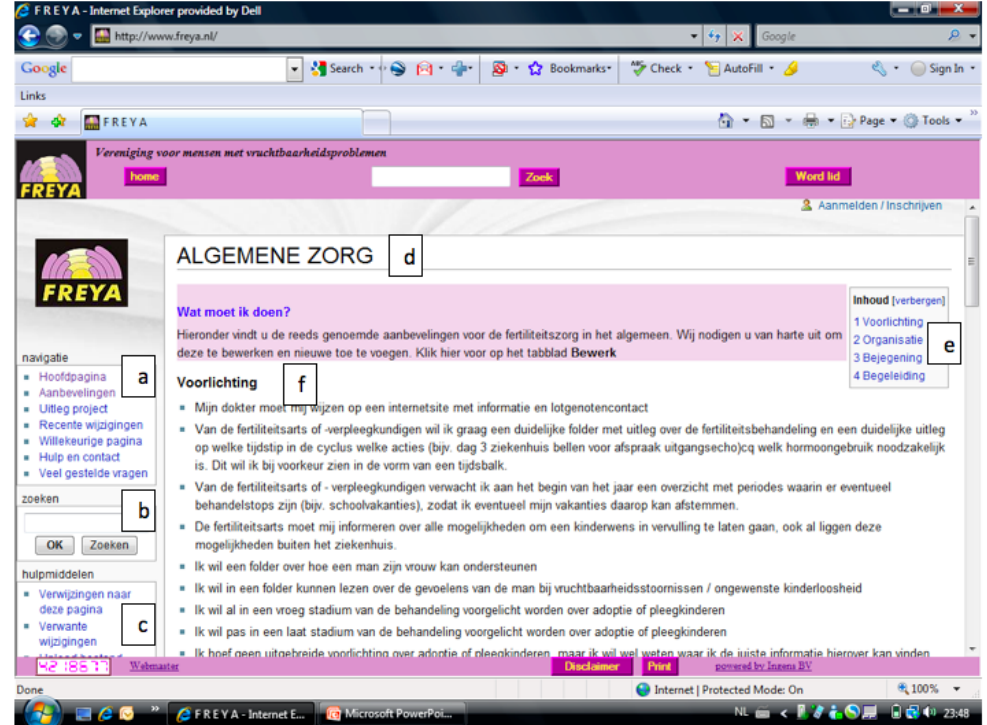
Figure 2. Screenshot of recommendations on